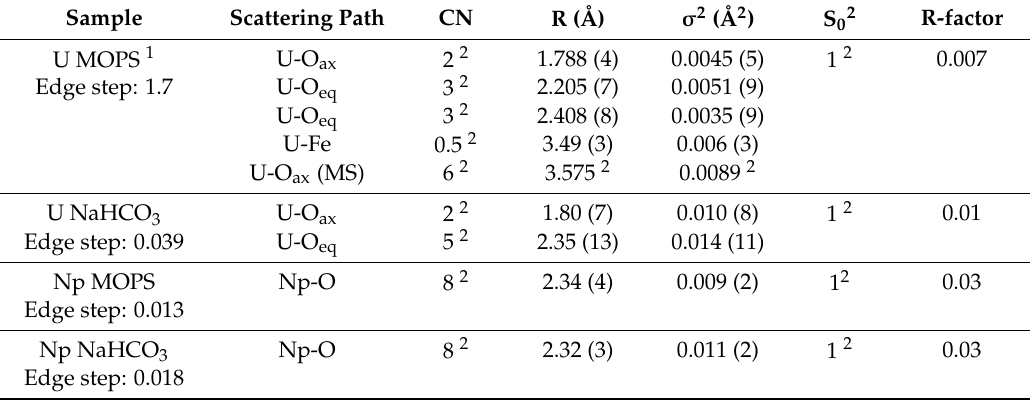
Table 1. Summary of the fits to the uranium and neptunium L III -edge EXAFS for spectra in (Figure 2b,c) U MOPS and U NaHCO 3 and Np MOPS and Np NaHCO 3 (Figure 3b,c) (CN: coordination number, R: radial distance, σ 2 : Debye-Waller factor and S 02 : amplitude correction factor, MS: multiple scattering); included is also the size of the XANES edge step before normalization (Figure 2a and Figure 3a). Sample